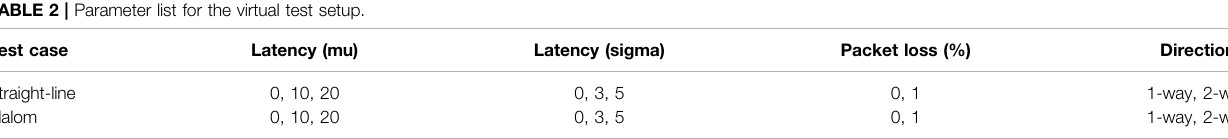
TABLE 2 | Parameter list for the virtual test